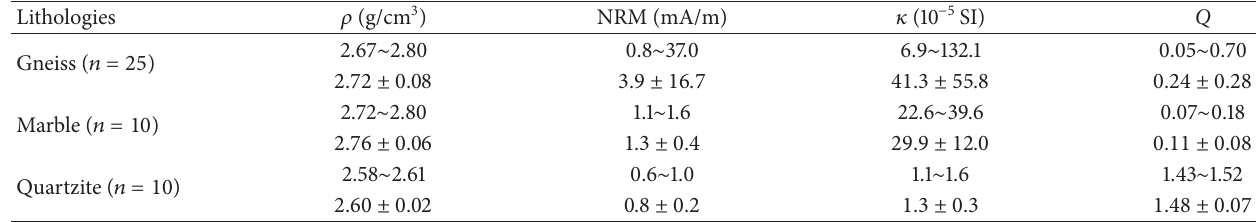
Table 4: Statistical results of 𝜌 , 𝜅 , NRM, and Q values of different metamorphic